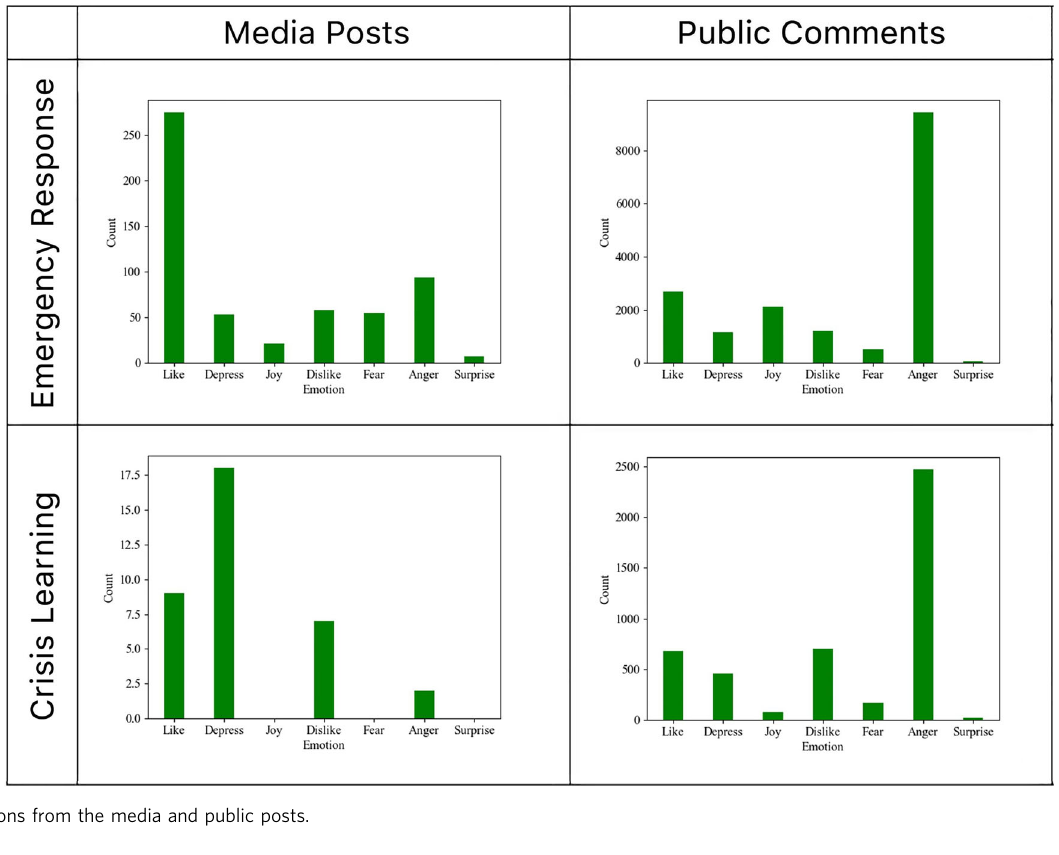
Fig. 3 Emotions from the media and public posts.